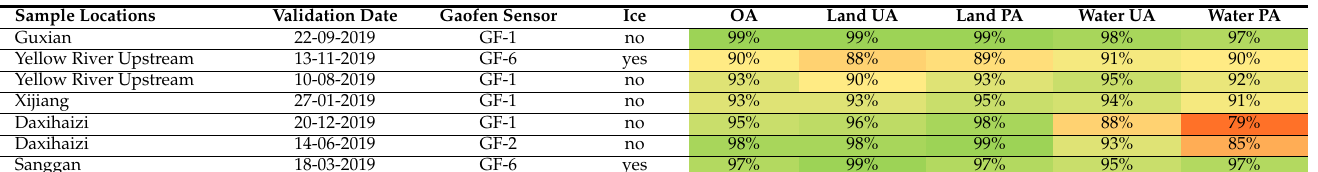
Table 1. Classification accuracies (%) displayed as a heat map for each of the five validation sites. OA = Overall accuracy, UA = User’s accuracy, PA = Producer’s accuracy.